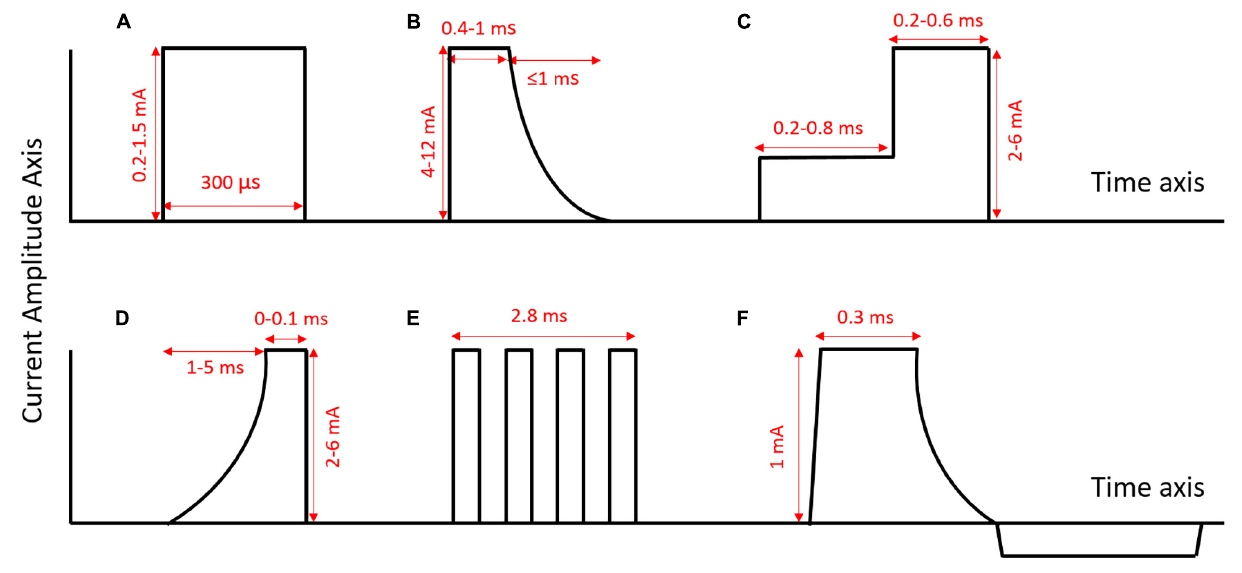
FIGURE 2 | Examples of different pulse shapes used in sVNS (axes not to scale). (A) Normal rectangular pulse [as used in Dali et al. (2018)]. (B) Anodal block pulse [as used in Vuckovic et al. (2008)]. (C) Depolarizing pre-pulse [as used in Vuckovic et al. (2008)]. (D) Slowly rising pulse [as used in Vuckovic et al. (2008)]. (E) Chopped pulse [as used in Dali et al. (2019)]. (F) Quasi-trapezoidal pulse [as used in Peˇclin and Rozman (2014)]. Rectangular pulses are the standard pulse shape used in the nerve stimulation. They are easy to generate, and their symmetry makes it easier to ensure charge balance. However, pulses with more unusual shapes, such as chopped pulses or pulses with ramped parts, allow for the delivery of current throughout the pulse to be adapted to specific